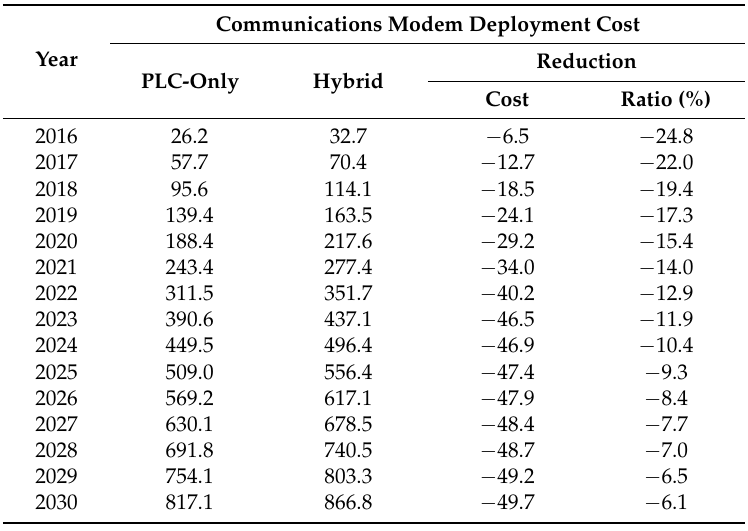
Table 9. Comparison of Communications Modem Cost Results per Deployment